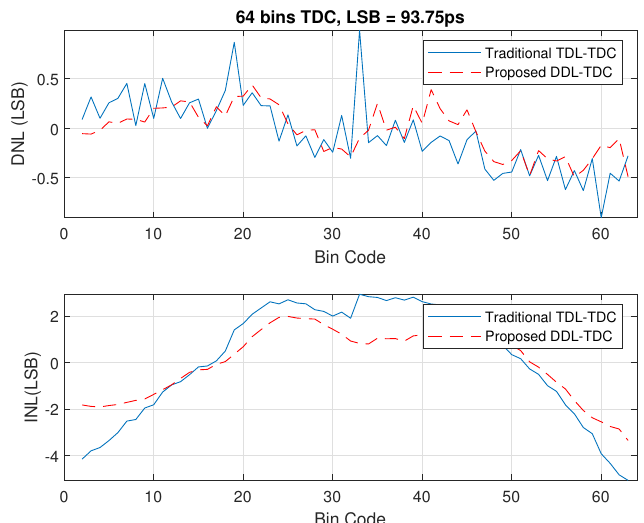
Figure 8. INL/DNL values obtained using the proposed DDL-TDC with 6-bit digital output.